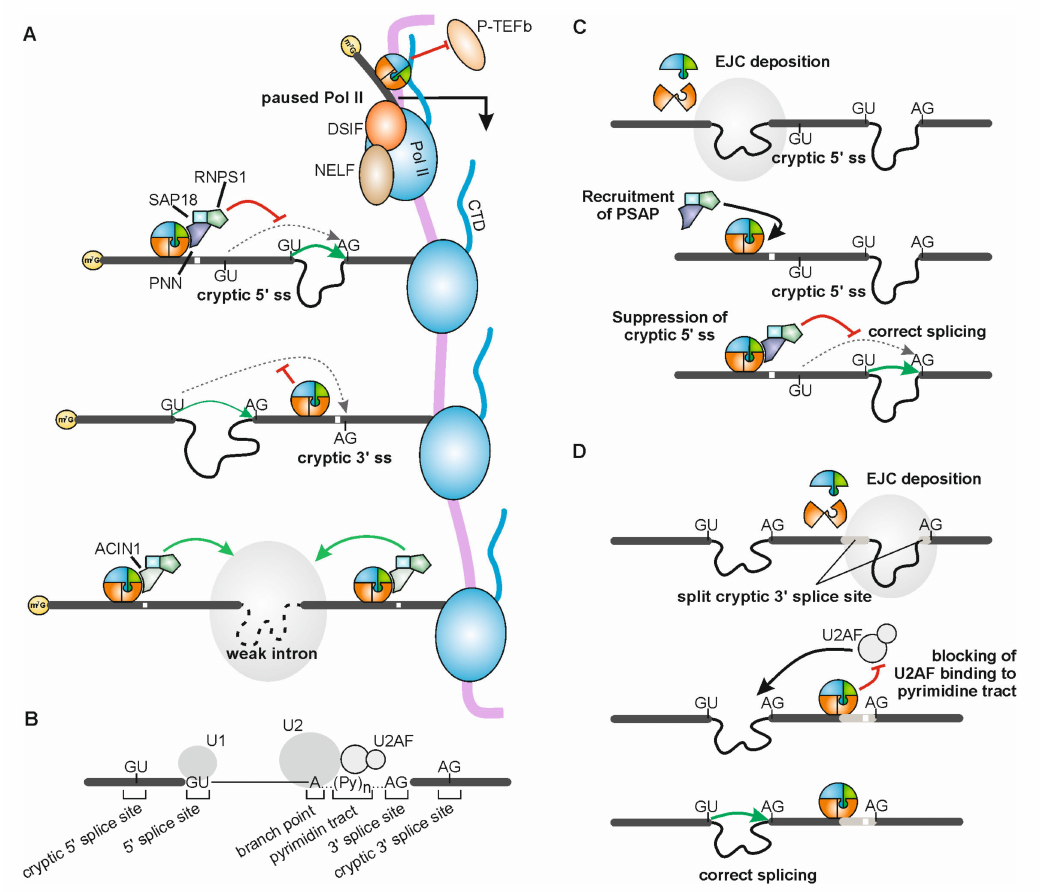
Figure 2. Mechanisms of splicing regulation by the EJC. ( A ) Non-canonical EJCs can bind to the mRNA at promoter regions and interact with the C-terminal domain (CTD) of paused Pol II, which is stabilized by DRB sensitivity-inducing factor (DSIF) and negative elongation factor (NELF). This prevents binding of the transcription elongation factor P-TEFb and thereby holds the Pol II in a paused state, which ensures proper splicing. Additionally, EJCs deposited at canonical sites enhance splicing of neighboring weak introns in Drosophila , potentially via the ASAP complex (ACIN1, depicted in grey-green color; SAP18, RNPS1). Furthermore, the EJC core represses the usage of reconstituted cryptic 3 (cid:48) splice cites by steric hindrance. RNPS1 as a PSAP (PNN, depicted in violet; SAP18; RNPS1) component represses cryptic 5 (cid:48) splice sites located downstream of the EJC. ( B ) Schematic representation of intronic sequences involved in splicing. The 5 (cid:48) splice site is bound by the U1 snRNP, the branch point by the U2 snRNP. U2AF (U2AF1 / U2AF2) recognize the pyrimidine tract and help recruiting the U2 snRNP. Cryptic 5 (cid:48) and 3 (cid:48) splice sites in exons resemble authentic splice sites, but are located outside the intron. ( C ) Stepwise model of cryptic 5 (cid:48) splice site repression by the EJC and the PSAP complex. In a first step, the EJC is deposited to an upstream exon-exon junction during splicing. Recruitment of RNPS1 as a PSAP component is su ffi cient to suppress usage of a nearby cryptic 5 (cid:48) splice site and thereby enables correct splicing of the downstream intron. ( D ) Stepwise model of cryptic 3 (cid:48) splice site repression by the EJC core. Splicing of the downstream intron reconstitutes a cryptic 3 (cid:48) splice site that is split across two neighboring exons. During splicing, the EJC is deposited at the exon-exon junction and thereby masks the reconstituted cryptic 3 (cid:48) splice site. The U2AF splice factor is therefore unable to bind to the pyrimidine tract of the cryptic splice site and splicing of the upstream intron is